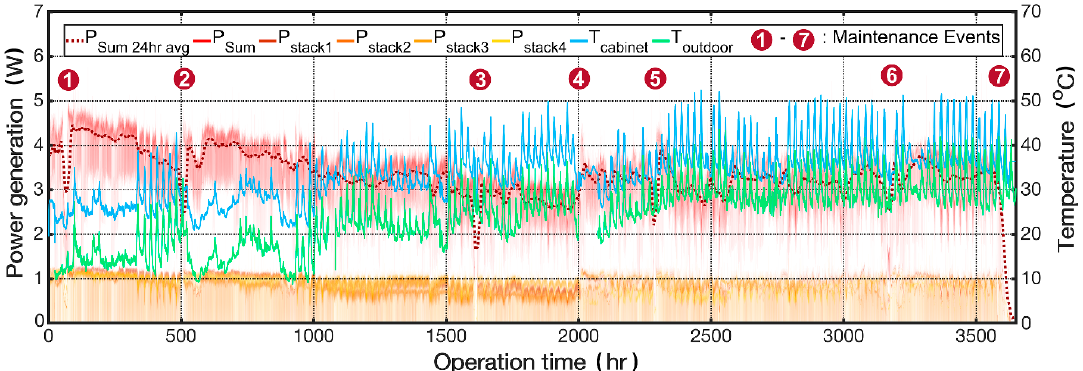
Figure 8. Long-term power-generation test data in an actual outdoor environment.